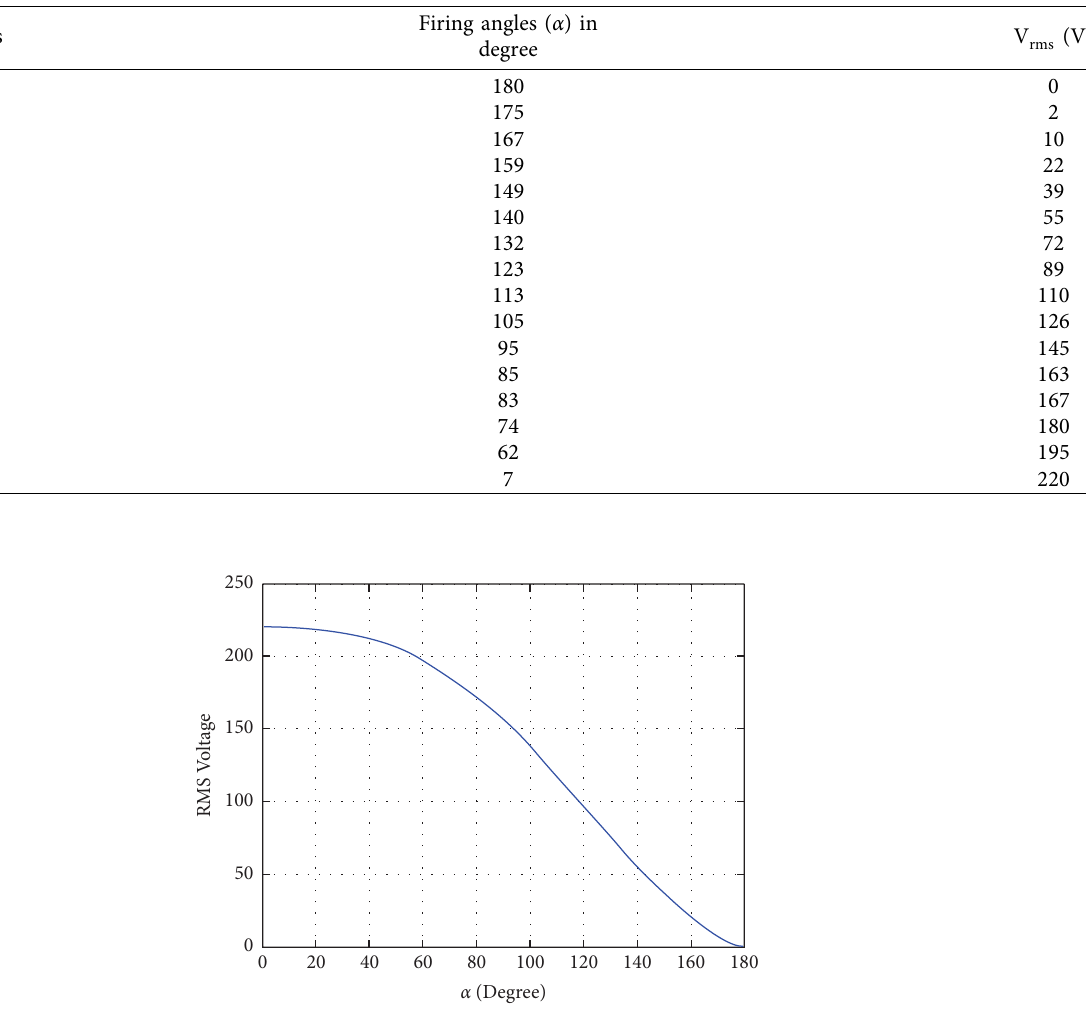
Table 6: Relation between fring angles and V